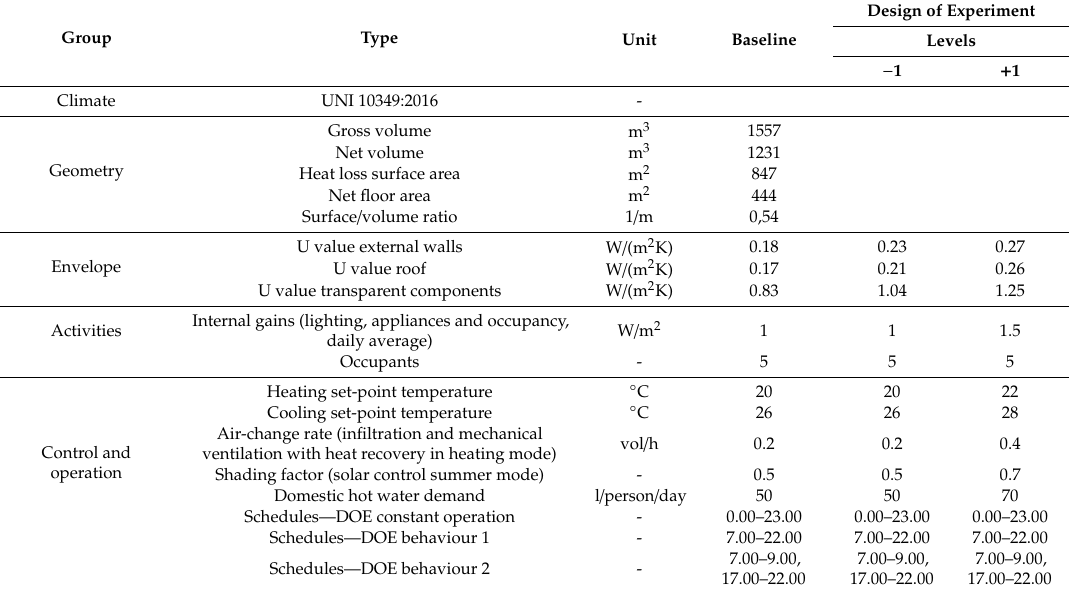
Table 1. Simulation data from baseline and two-level Design of Experiments